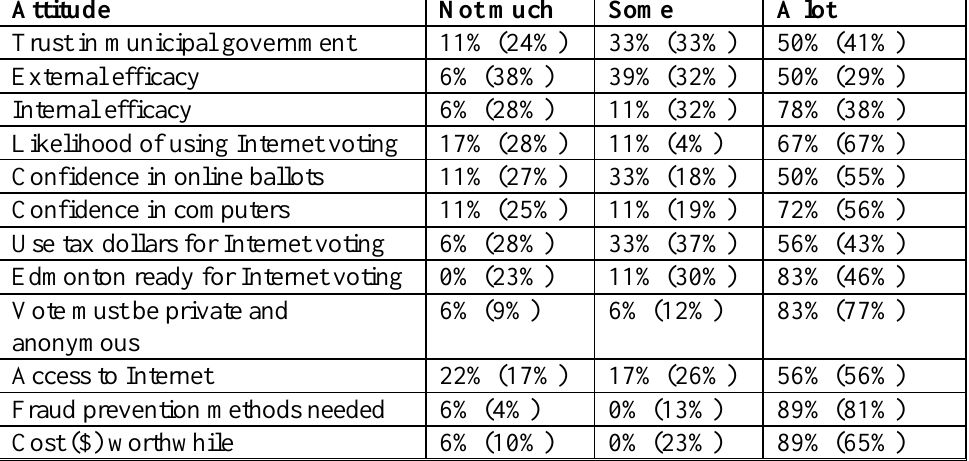
Attitudinal characteristics of Jury members and the Edmonton population Attitude Not